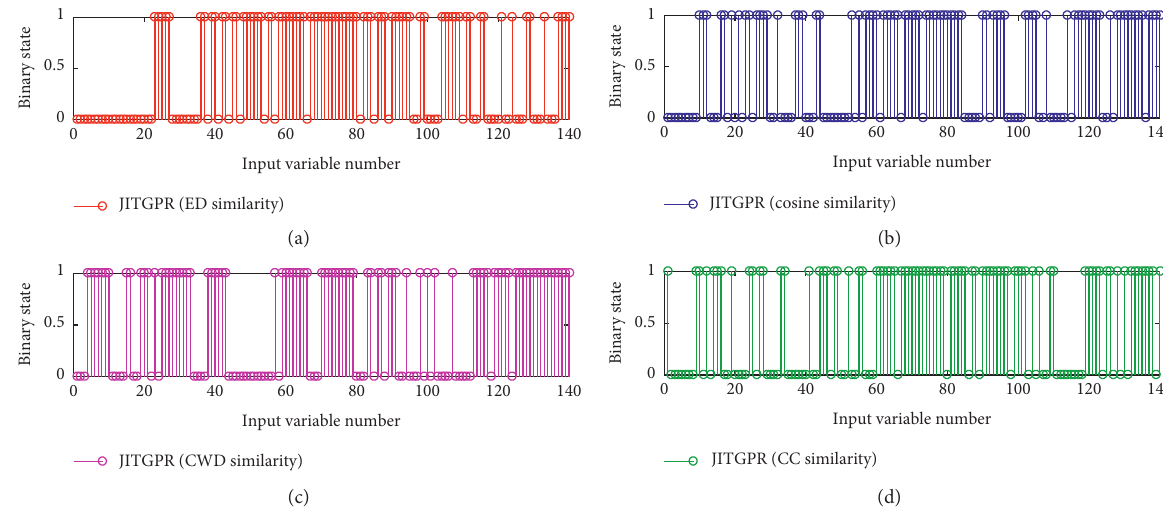
Figure 6: Input variable selection results for various similarity measures using EMO optimization. (a) JITGPR (ED similarity). (b) JITGPR (cosine similarity). (c) JITGPR (CWD similarity). (d) JITGPR (CC similarity).